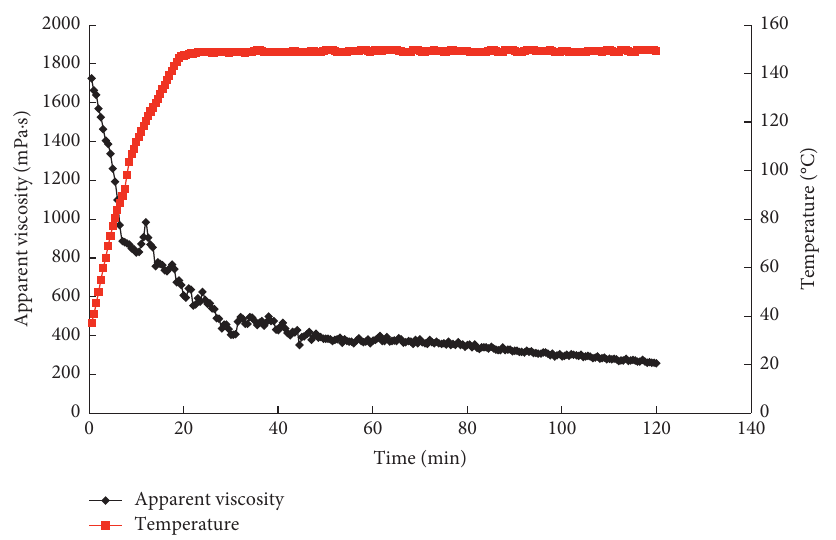
Figure 8: Temperature and shear resistance of the high-density fracturing fluid of formula 3 at 150 ° C.